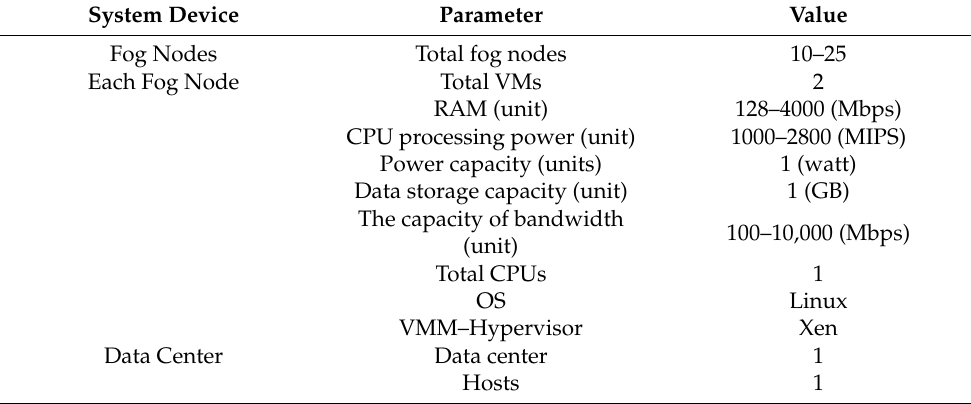
Table 2. Configuration of fog